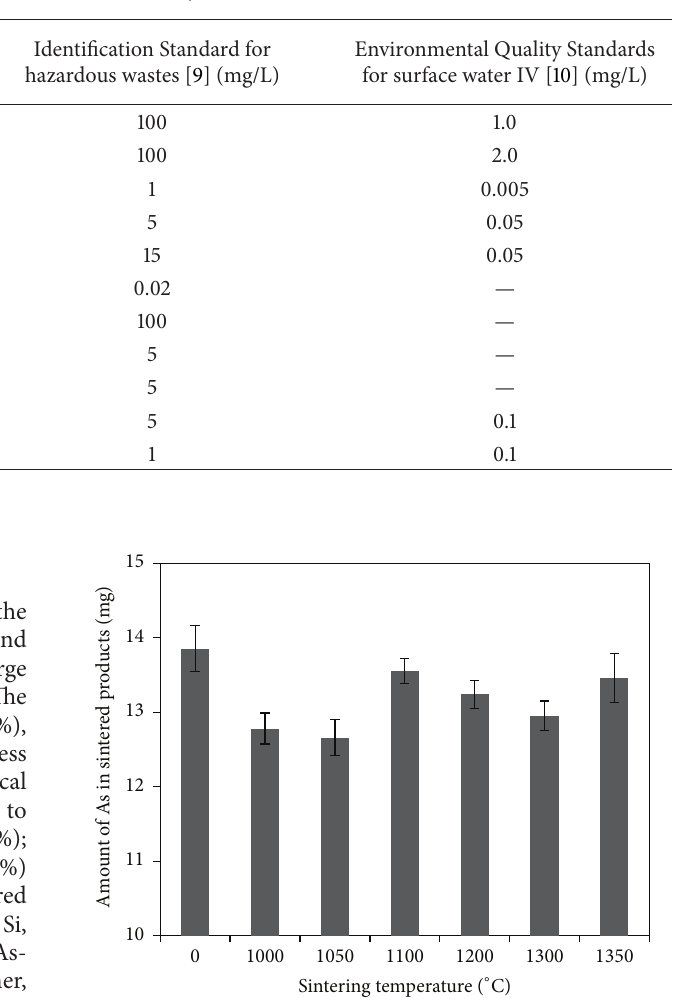
Figure 2: Effect of sintering temperature on the total amount of As in sintered products.